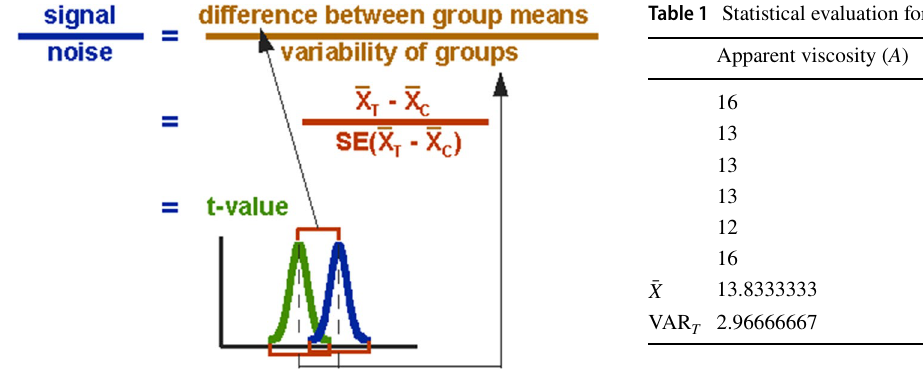
Fig. 6 Formula for the t test